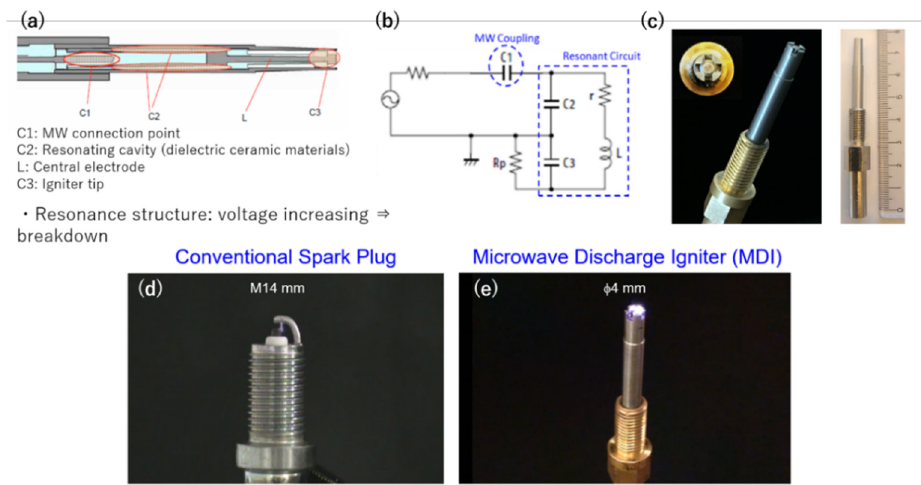
Figure 7. ( a ) Schematic diagram, ( b ) equivalent circuit, ( c ) and actual image of microwave discharge igniter (MDI). Actual scale size is compared with that of a ( d ) conventional spark plug. ( e ) Actual ignition of MDI.